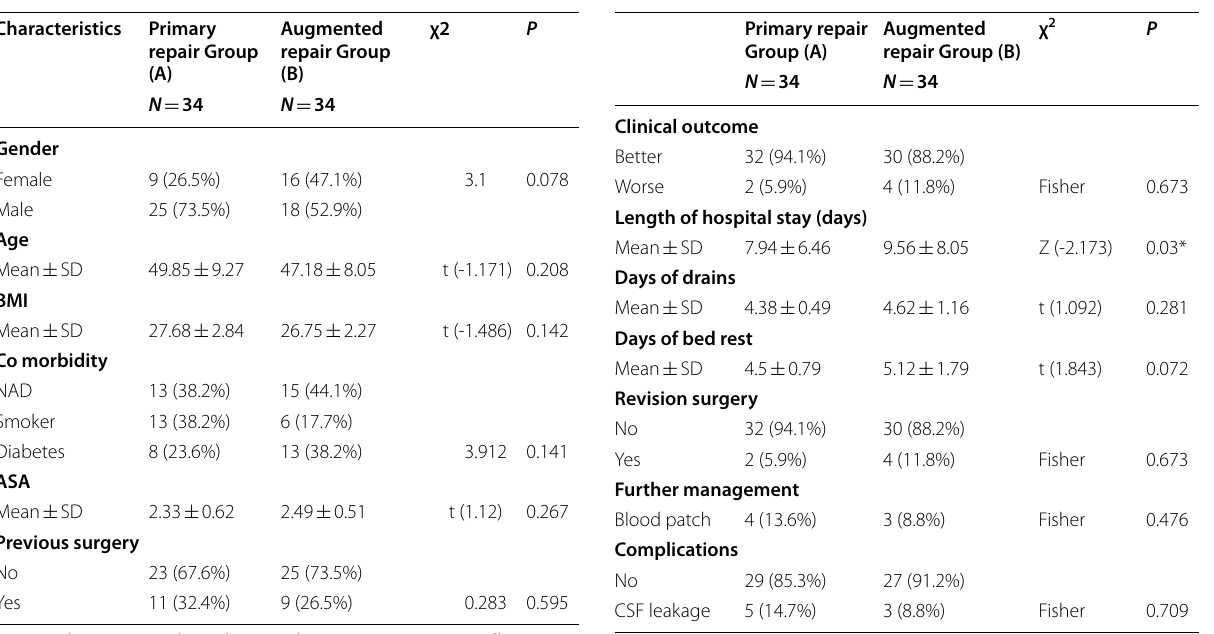
Table 3 Primary and secondary outcome of the studied groups